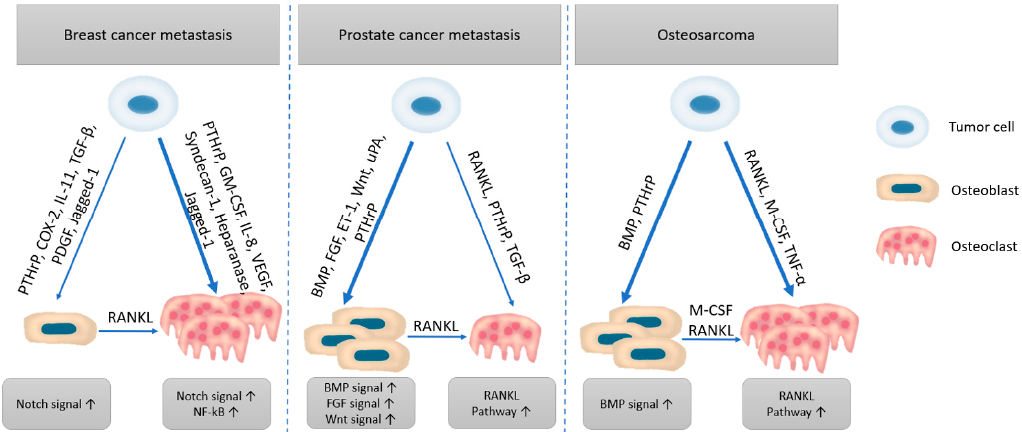
Figure 4. Comparison of bone tumor microenvironment in metastasis versus sarcoma. Created based on information from literature references [36,42–45].